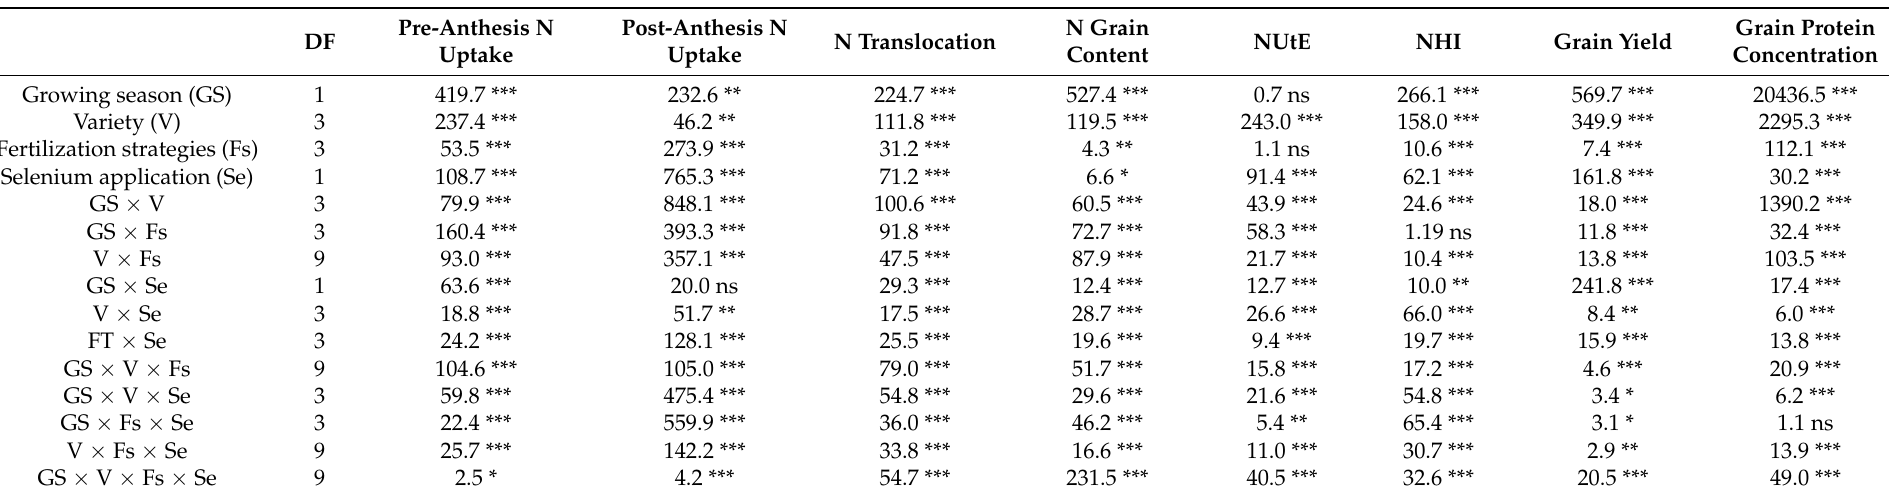
Table 1. F-value relative to growing season (GS), variety (V), fertilization strategy (Fs), Selenium application (Se) and their interactions resulting from analysis of variance (ANOVA) performed on pre-anthesis N uptake, post-anthesis N uptake, N translocation, nitrogen utilization efficiency (NUtE), nitrogen harvest index (NHI), N grain content, grain yield and grain protein